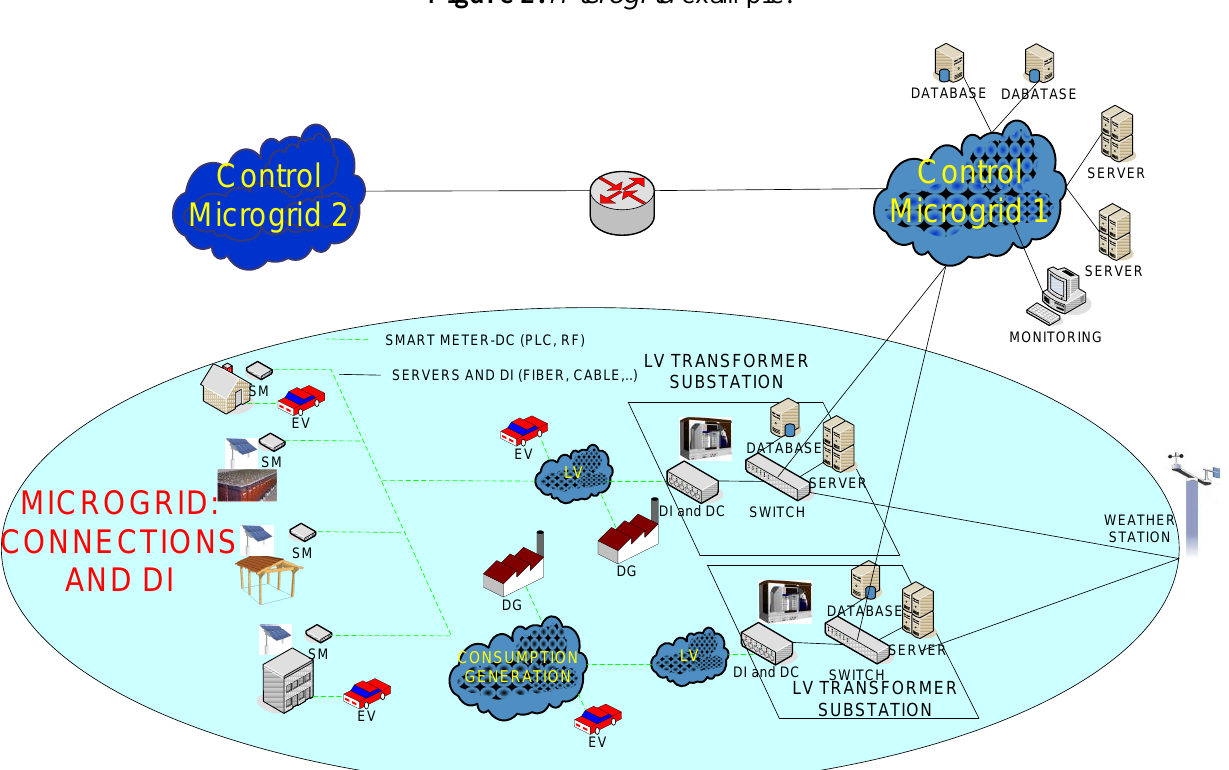
Figure 2. Microgrid